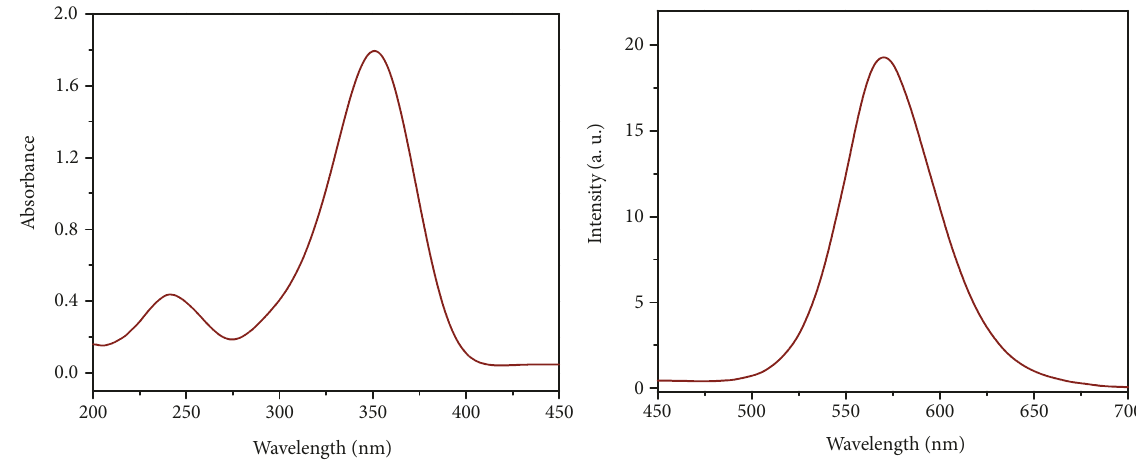
Figure 2: The optical properties include UV-Vis and emission spectra of the